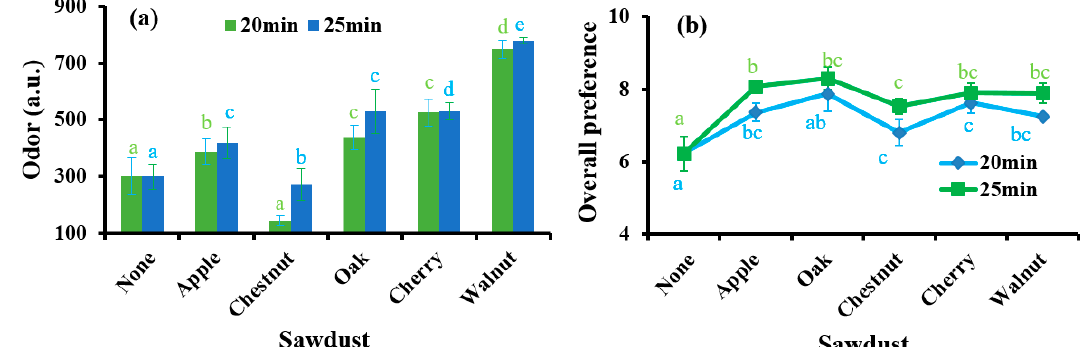
Figure 1. Effect of various sawdust (apple, chestnut, oak, cherry, and walnut) materials on instrumental odor intensity ( a ), and overall preference based on sensory attributes ( b ) in hot smoked chub mackerel (CM) fillet at two smoking times (20 and 25 min). Data were expressed as mean ± std (n = 10), where different letters were statistically different ( p < 0.05).